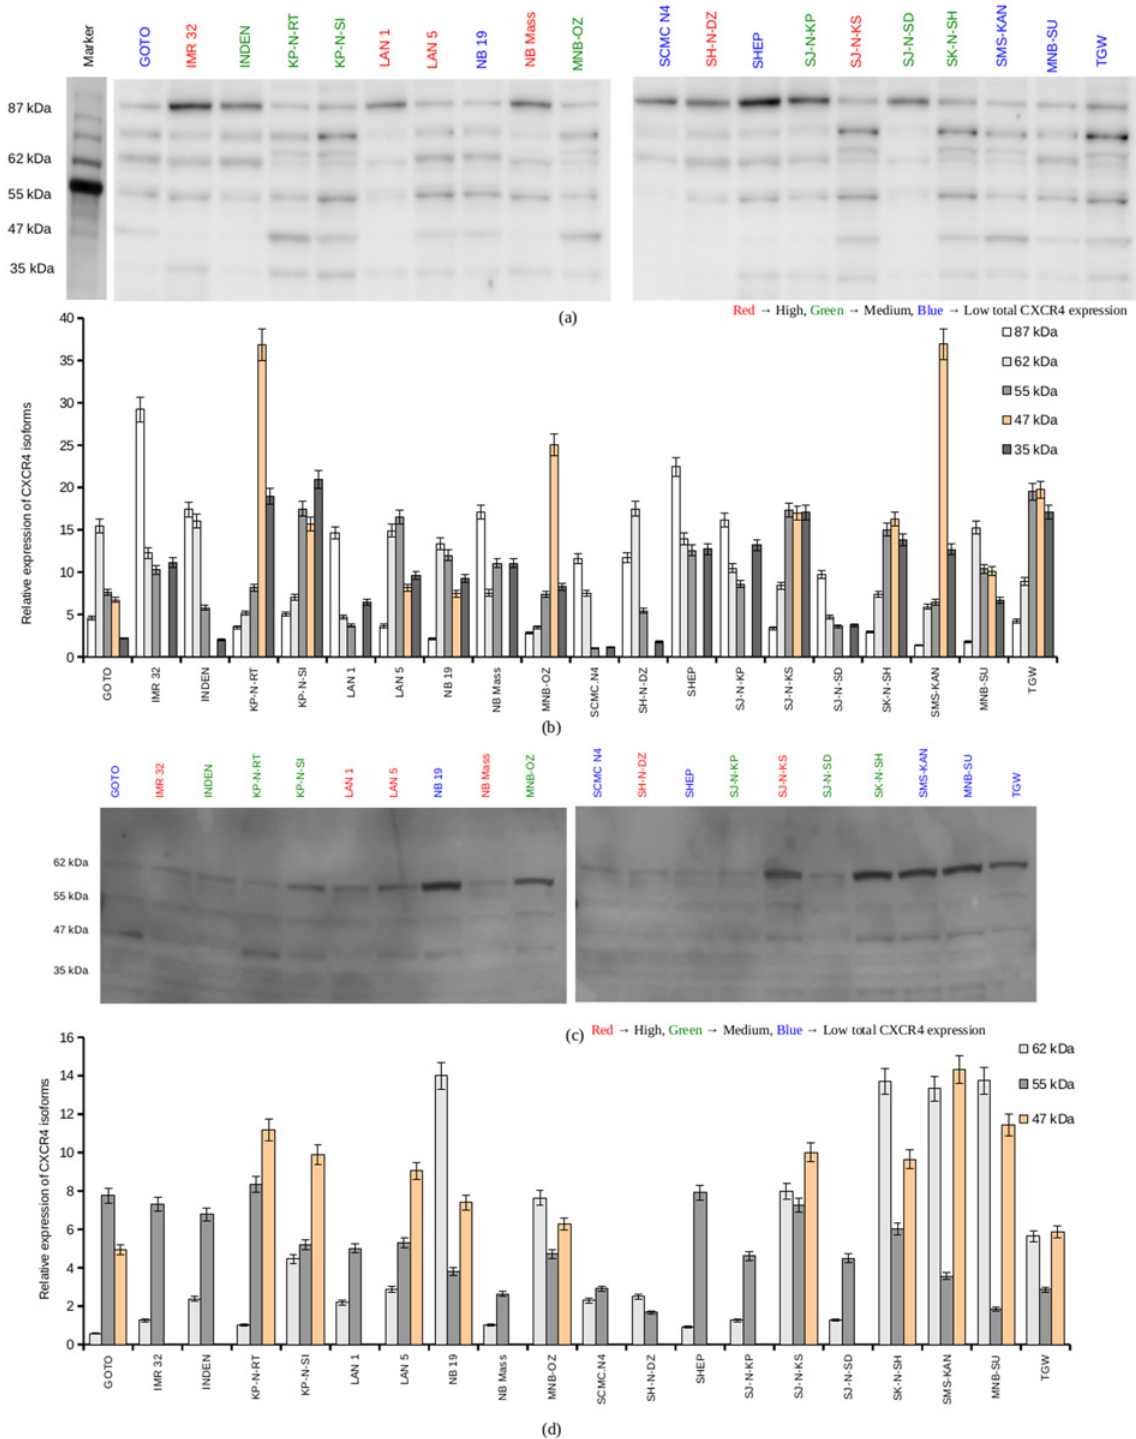
Fig 3. Structural heterogeneity of CXCR4 in neuroblastoma cell lines. a. Western blot detection of CXCR4 in 20 neuroblastoma cell lysates. 1 X 10 7 cells were washed twice in PBS and solubilized in 1 ml of lysis buffer. The lysates were centrifuged at 14,000 rpm at 4°C for 30 minutes. Equal amounts of total proteins, as determined by BCA assay, were loaded on to a 12.5% polyacrylamide gel and electrophoresed. The proteins were then blotted on to a PVDF membrane and CXCR4 was detected using an anti-CXCR4 polyclonal antibody and a HRP conjugated secondary antibody. Shown in figure is a representative result from 5 experiments. b. The bands from western blot studies were quantified using imageJ. Plotted is the mean relative expression of